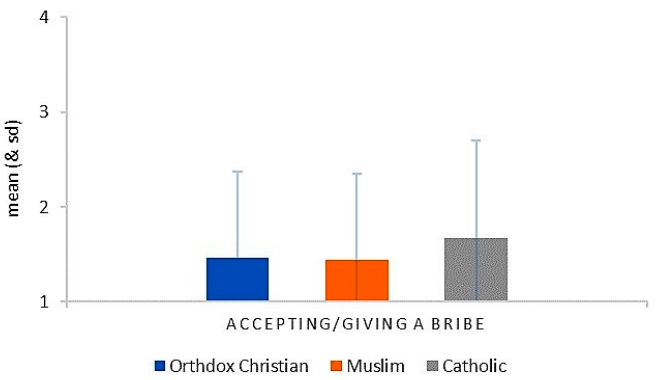
Figure 10. Accepting/giving a bribe. (The error bars represent standard deviation).